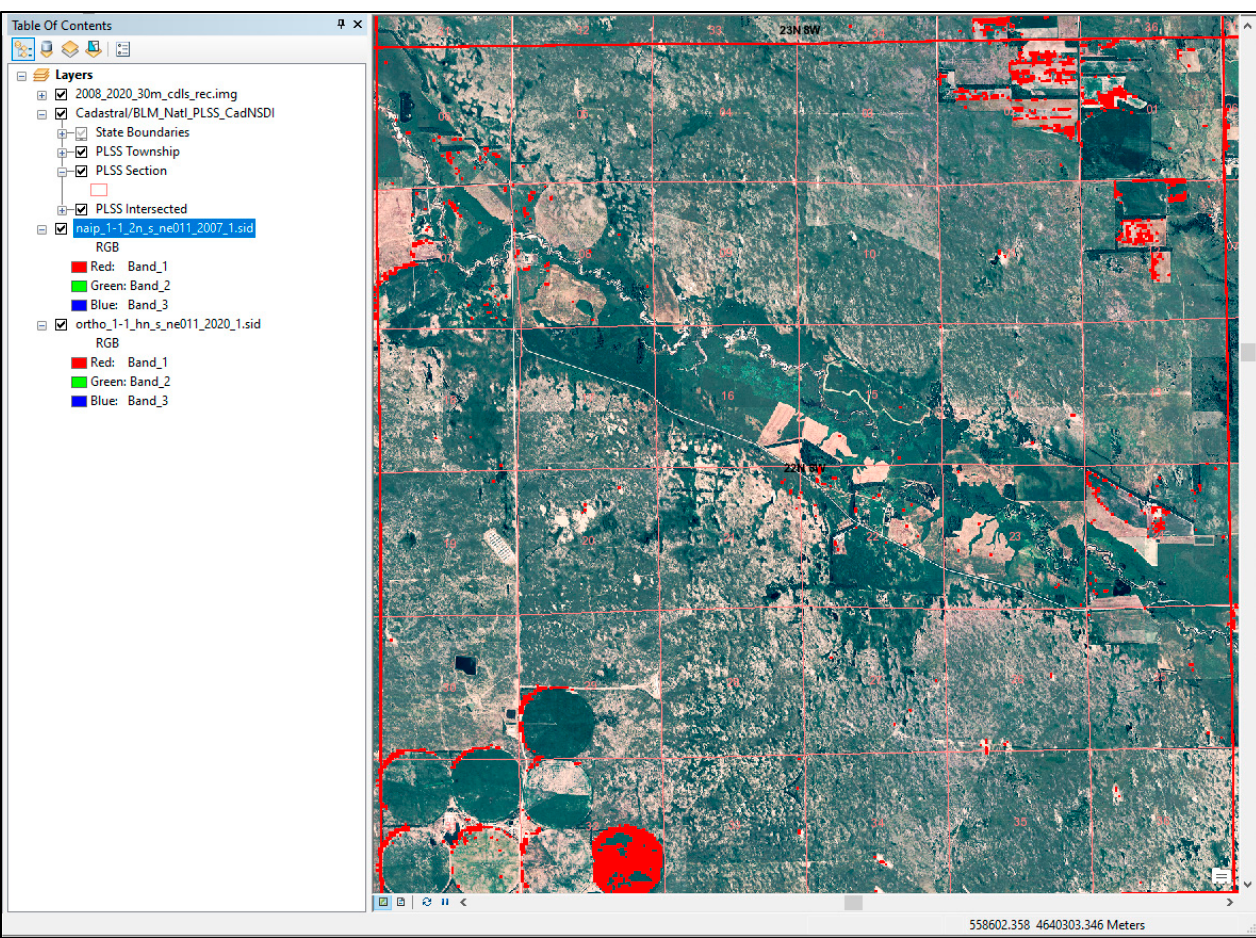
Figure 4. Example of viewer settings and layers for a county in Nebraska.